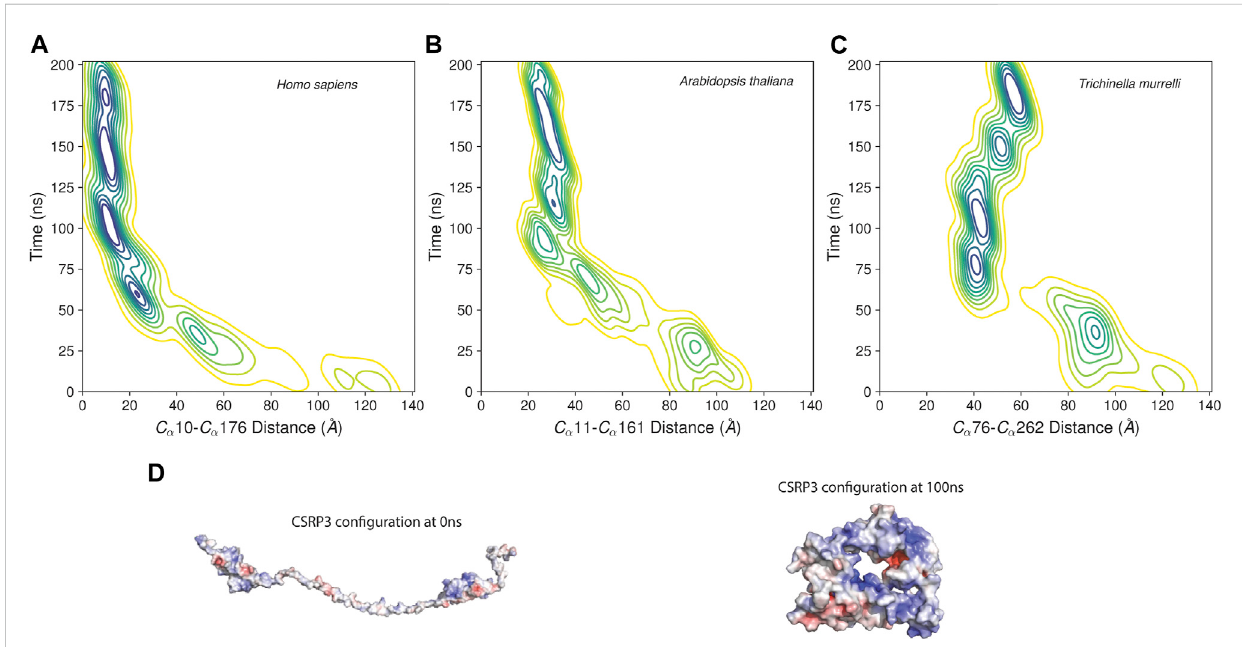
FIGURE 5 Distance between LIM1and LIM2as function oftimeinMDsimulation. (A – C) Contour mapofdistancebetween twoLIMdomainsofhumanCSRP3, Arabidopsis LIMdomainprotein,andnematodeCSRP2.ThedistanceismeasuredbetweenalphaCatomsofCysandPheresiduesmarkingthebeginning and end of N-terminal LIM and C-terminal LIM domains. (D) Electrostatic map of CSRP3 at the 0th frame and 100 ns frame.